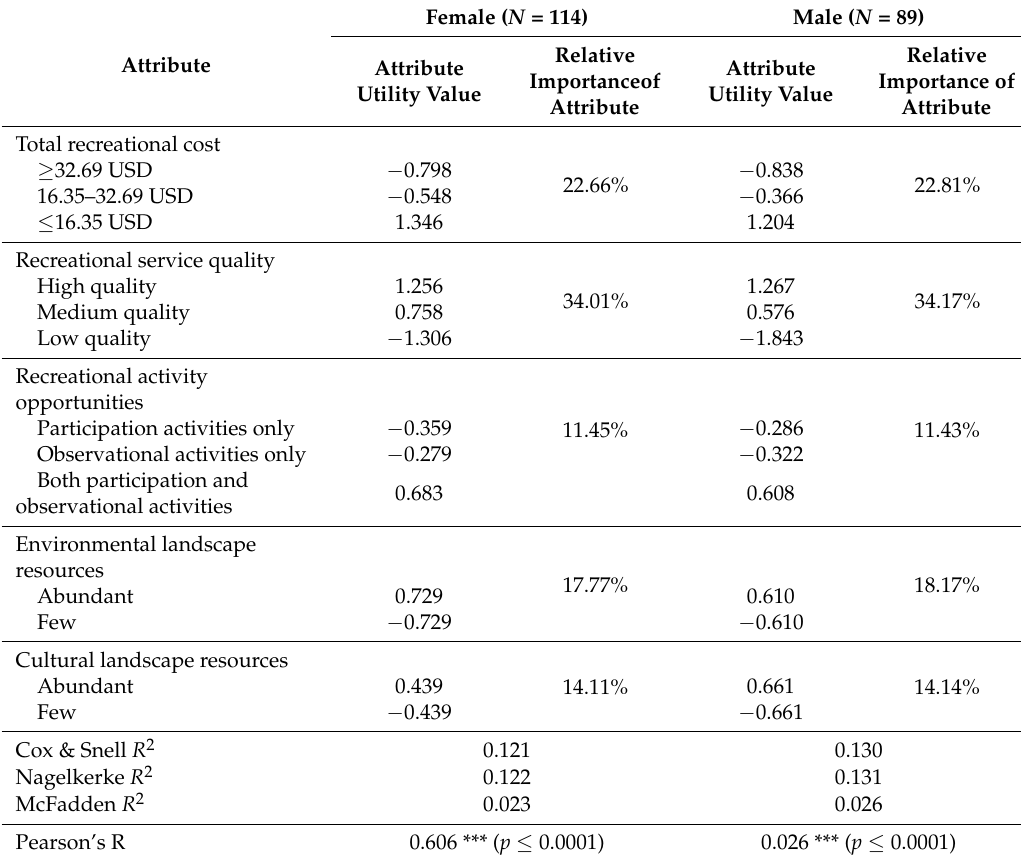
Table 7. Comparison of the results for the preferences of male and female visitors to the Calligraphy